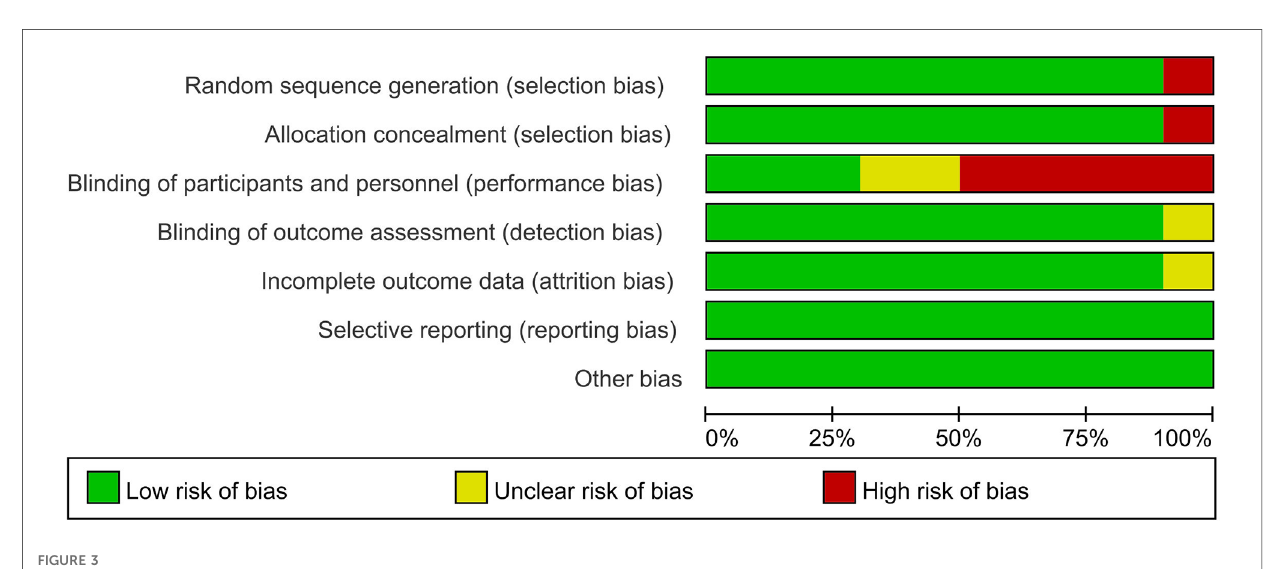
FIGURE 3 Risk of bias